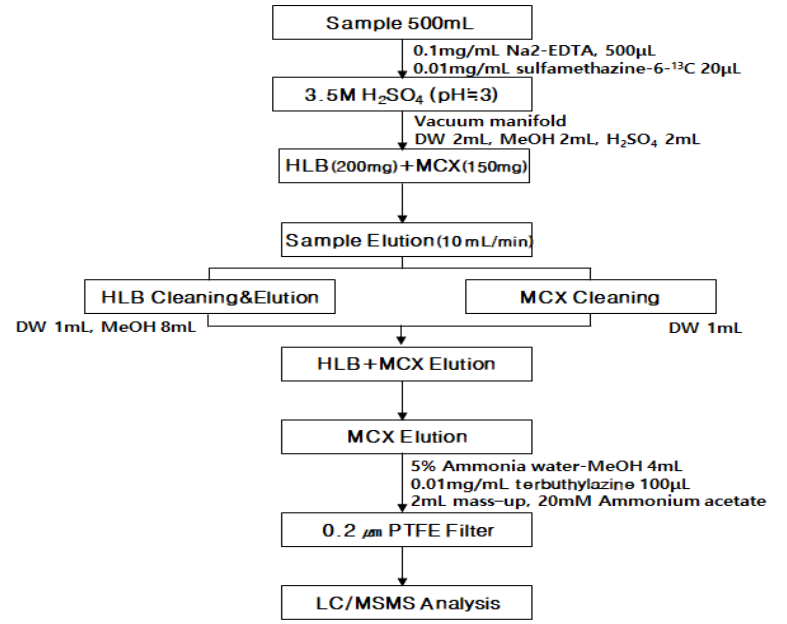
Figure 1. Sample pretreatment and